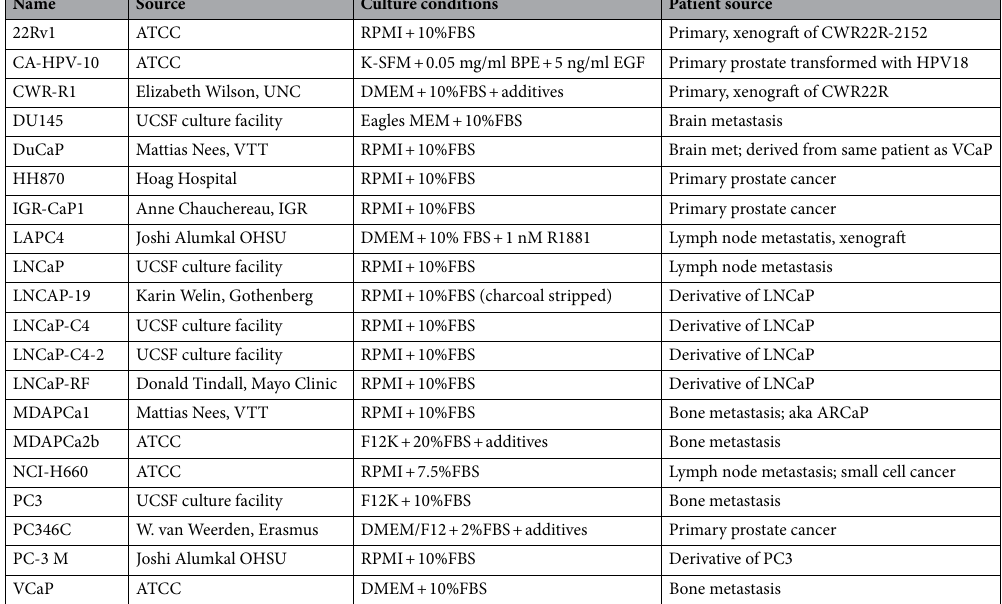
Table 1. Prostate cell line panel listing provider, growth conditions, and source of tumor used to establish the cell line. Cell lines from ATCC and UCSF can be obtained